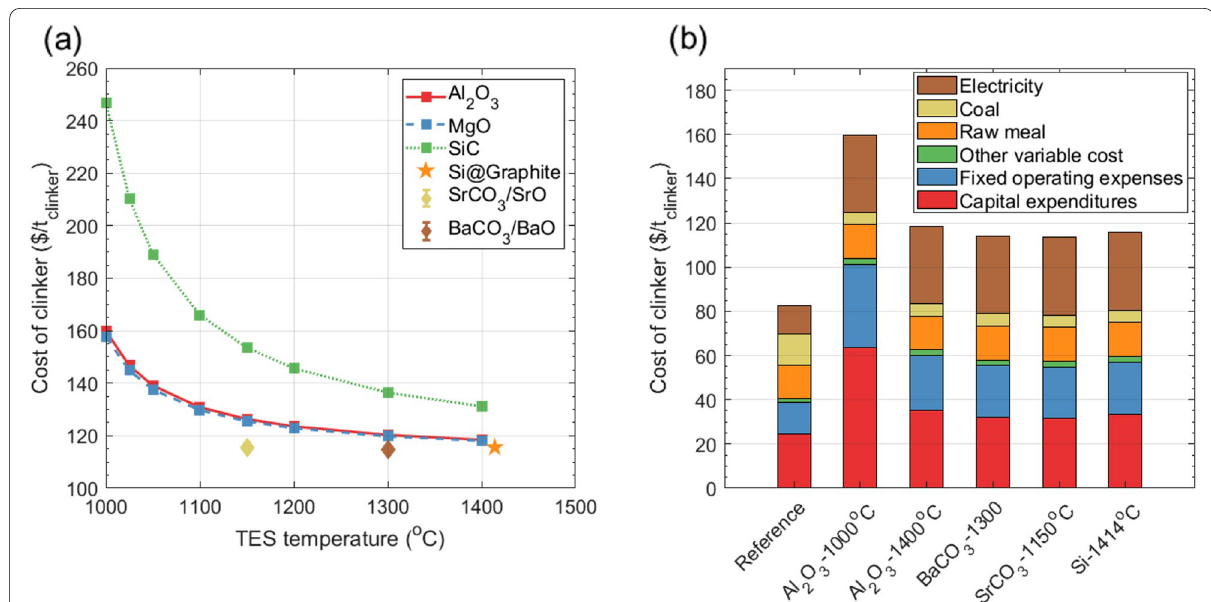
Fig. 8 The influence of TES materials and working temperature on the economic performance of the TES-based manufacturing